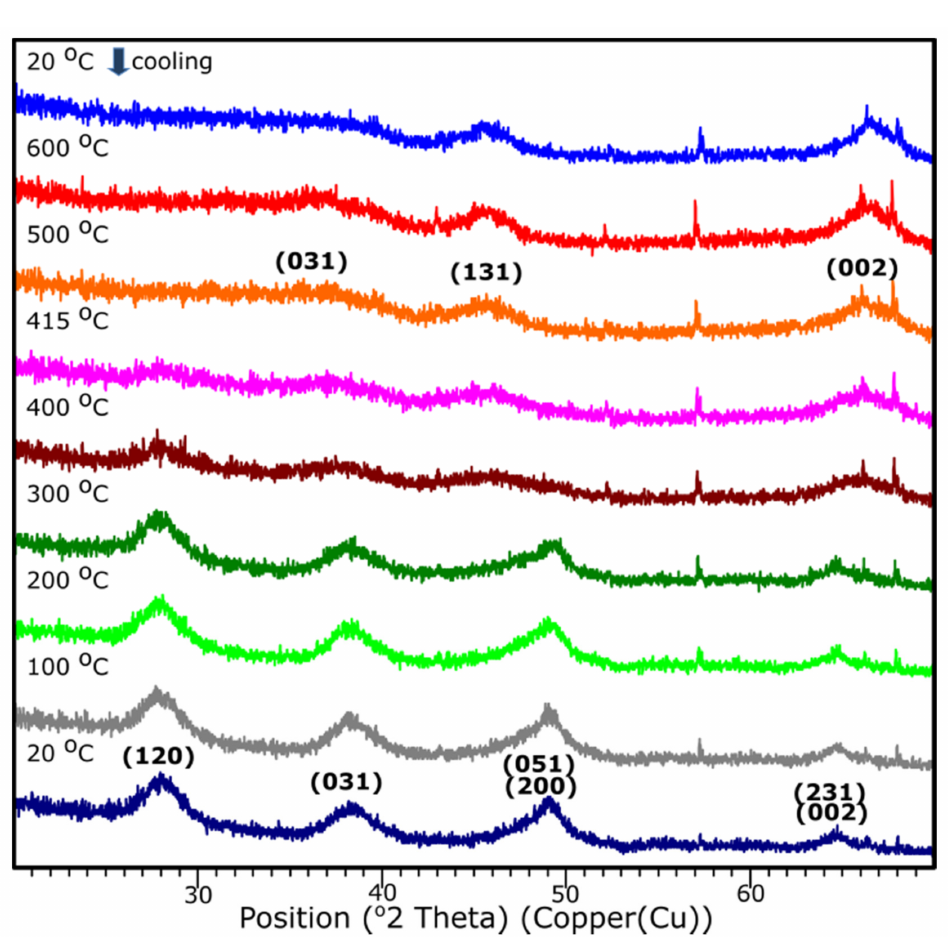
Figure 9. XRD diffraction patterns of the sample S1 with the temperature growth from 20 to 600 ◦ C and subsequent cooling to 20 ◦